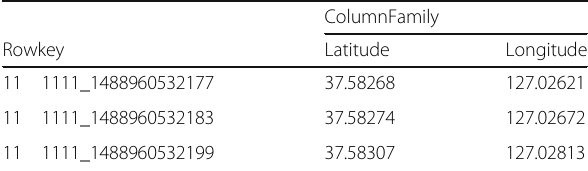
Table 1 Sample HBase table schema